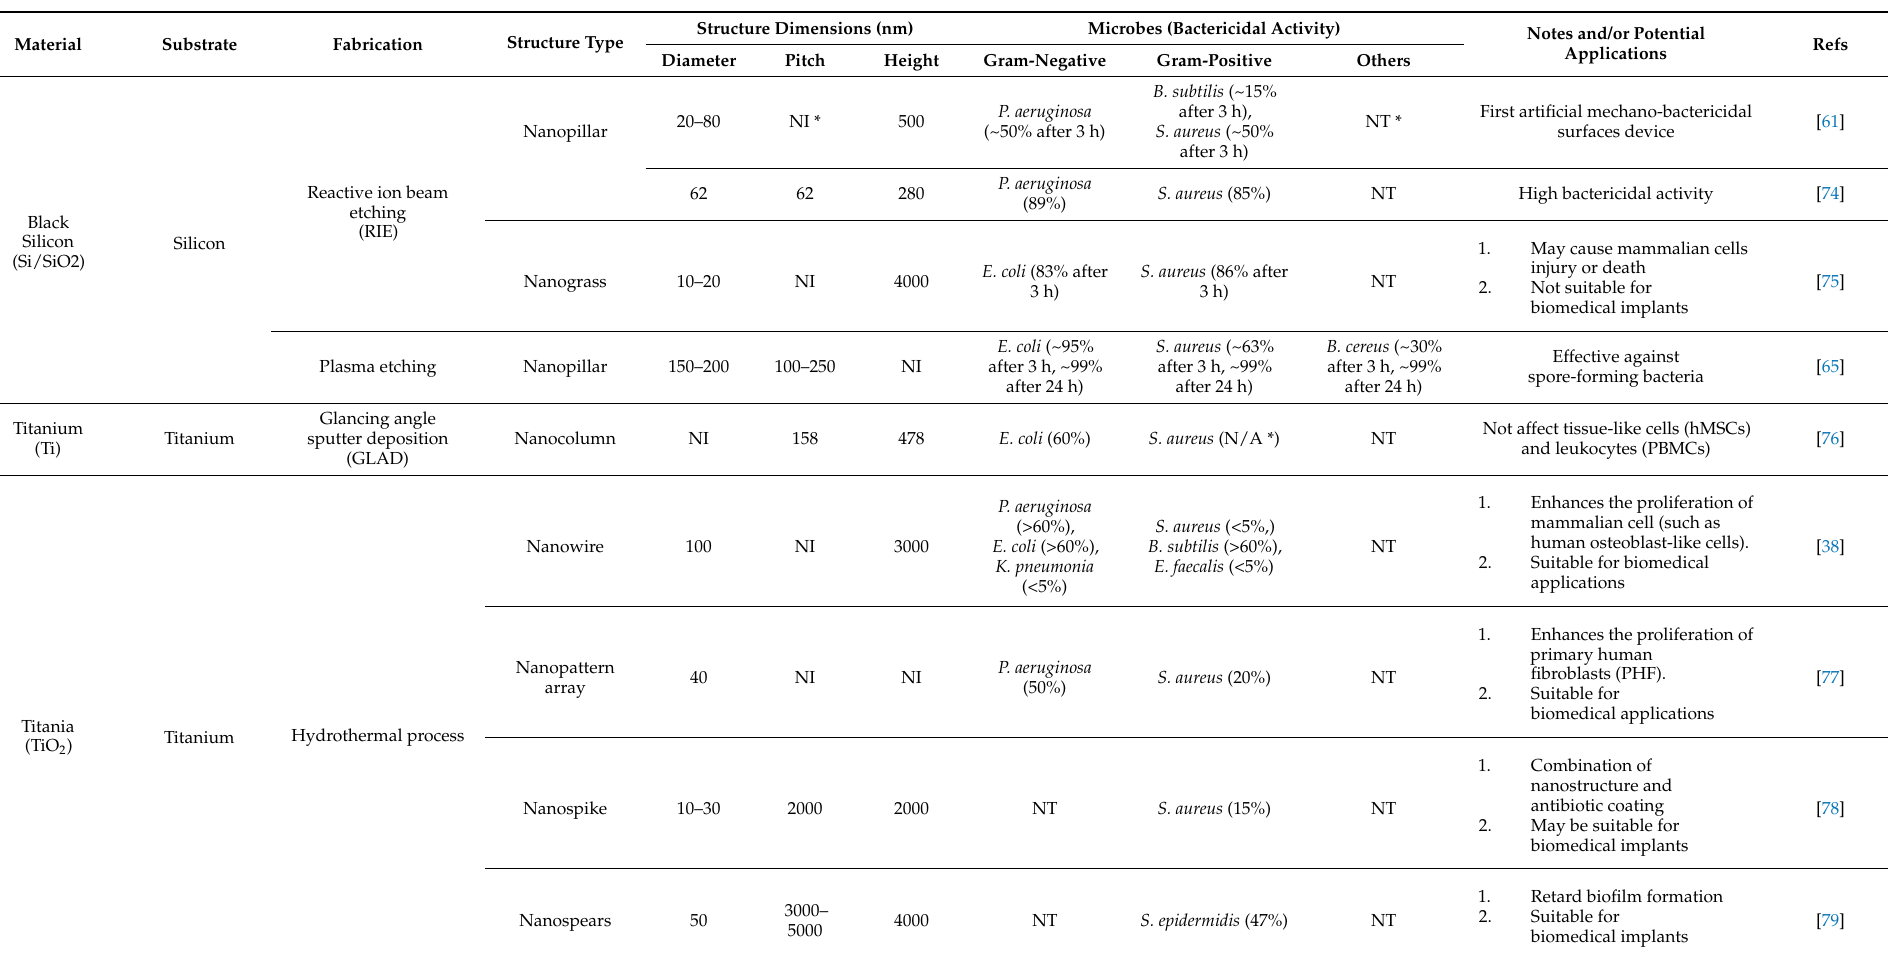
Table 1. Summary of artificial mechano-bactericidal